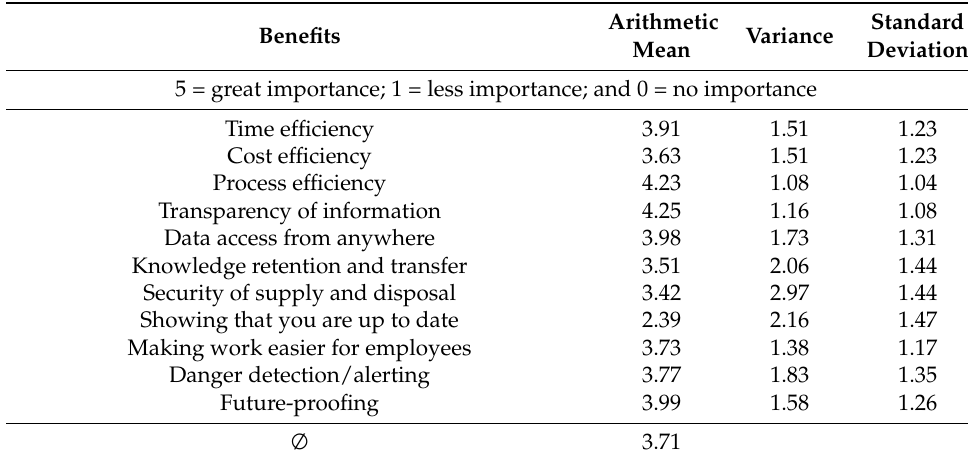
Table 4. Expected benefits from digitization projects ( n = 88).